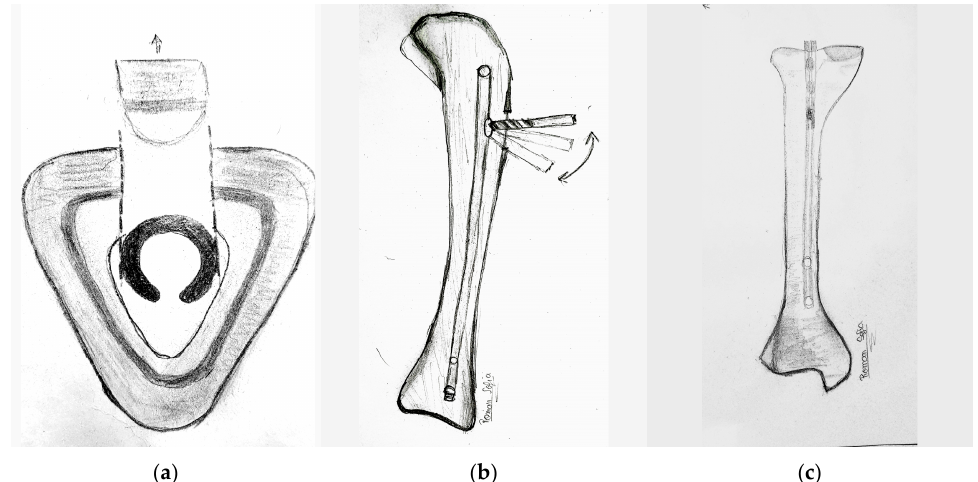
Figure 19. Tibial cortical windowing, creating a hole, and retrograde punching. ( a ) Anterior strategic window in the tibial bone. ( b ) Making a hole in the nail and punching it out. ( c ) The nail progresses proxi-mally by repeating it.